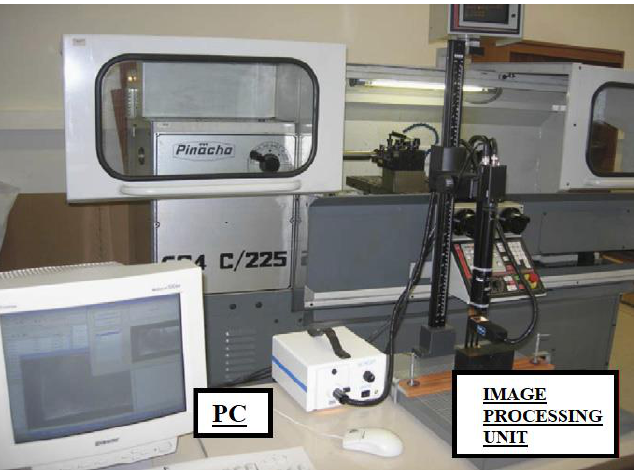
Figure 10. An example for image processing based tool condition monitoring system [77].